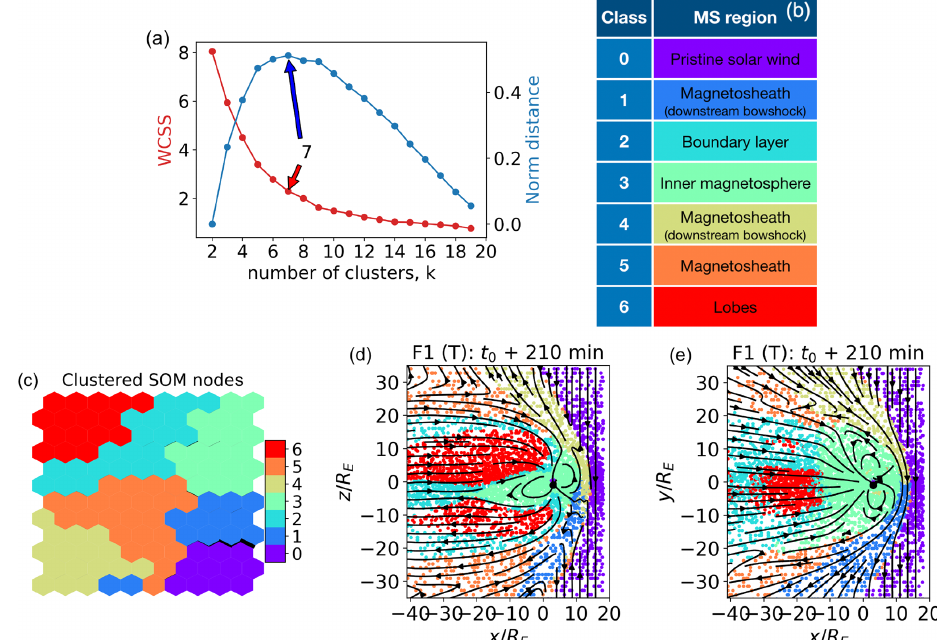
Figure 4. (a) Kneedle determination of the optimal number of k-means clusters for the SOM nodes. WCSSs (left axis) is the within-cluster sum of squares, the maximum of the normalized distance (right axis) identifies the optimal cluster number (here k = 7). (b) A posteriori class identification. (c) Clustered SOM nodes. (d, e) Classified points in the meridional and equatorial planes, respectively. In panels (b) to (e) , k = 7. The points depicted are the ones used for the training (T) of the